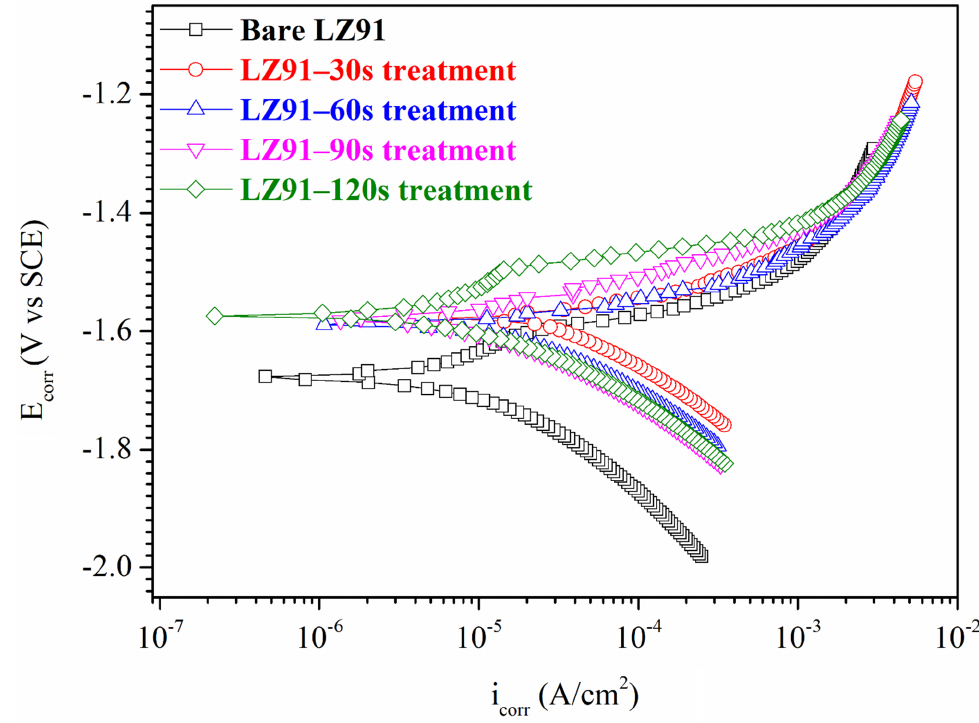
Figure 5. Potentiodynamic polarization curves for bare LZ91 and samples that undergo acid pickling pretreatment in 3.5 wt.% NaCl solution for different times.